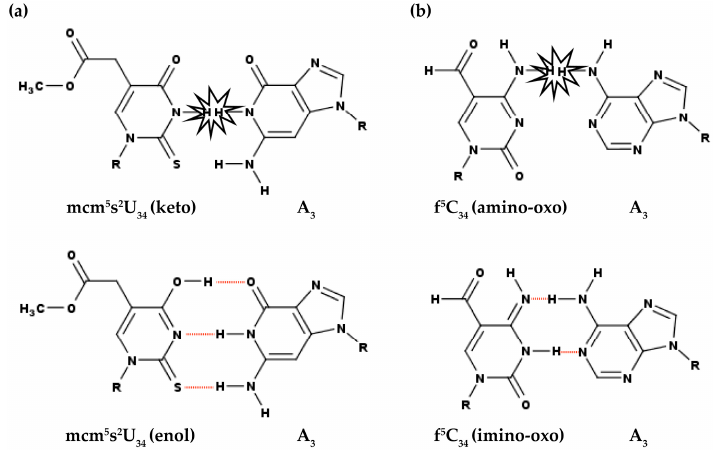
Figure 4. Modification ‐ induced tautomerism allows the wobble residue to base pair with a non ‐ cognate residue in the third codon position. ( a ) The keto form (Upper) of mcm 5 s 2 U 34 encounters steric hindrance when forming a Watson–Crick base pair with adenosine; while the enol form (Lower) allows for favorable hydrogen bonding; ( b ) The common amino ‐ oxo form (Upper) of f 5 C 34 is sterically prohibited from forming a Watson–Crick base pair with adenosine; while the imino ‐ oxo form (Lower) hydrogen bonds favorably.